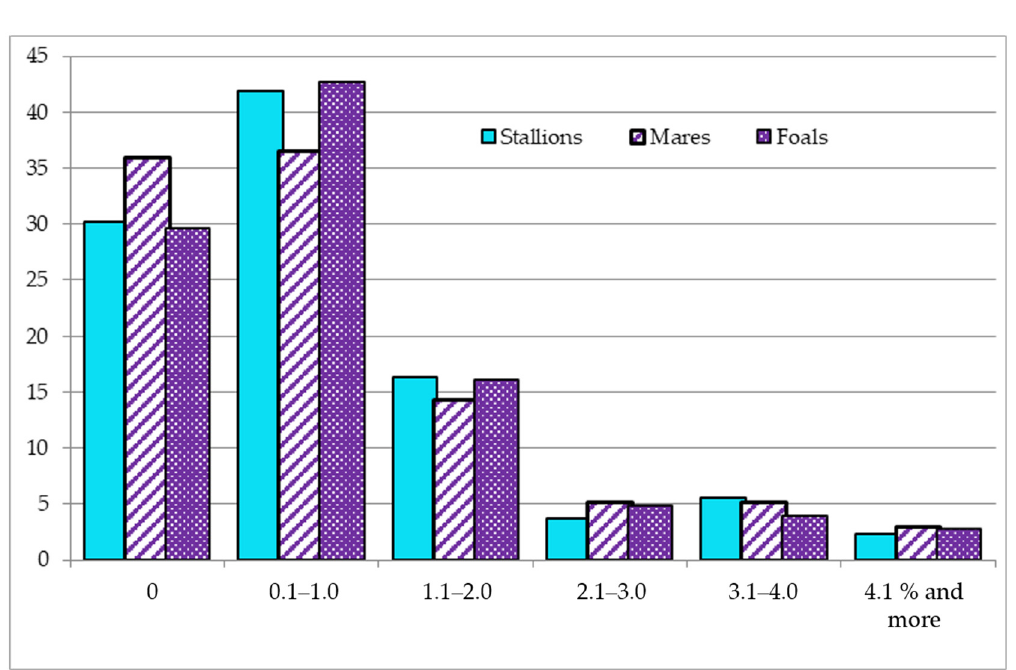
Figure 1. Distribution of Thoroughbred (TB) horses by inbreeding coefficient (Fx) in the period 2009– Distribution of Thoroughbred (TB) horses by inbreeding coe ffi cient (Fx) in the 2018. period